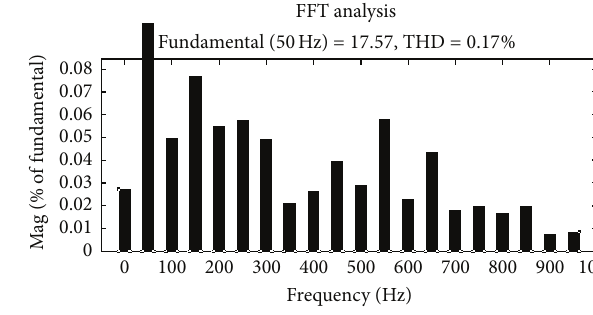
Figure 13: Load current THD